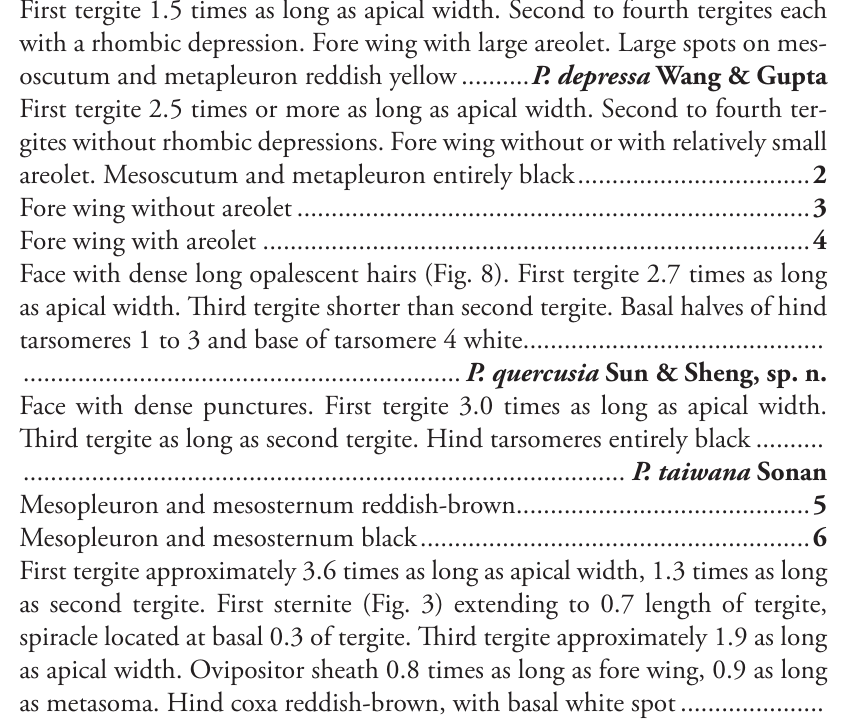
– 5 First tergite approximately 3.6 times as long as apical width, 1.3 times as long as second tergite. First sternite (Fig. 3) extending to 0.7 length of tergite, spiracle located at basal 0.3 of tergite. Third tergite approximately 1.9 as long as apical width. Ovipositor sheath 0.8 times as long as fore wing, 0.9 as long as metasoma. Hind coxa reddish-brown, with basal white spot ..................... ........................................................................... P. maculata Sheng & Sun – First tergite approximately 2.9 times as long as apical width, 1.1 times as long as second tergite. First sternite (Fig. 2) extending to 0.5 length of tergite, spiracle located slightly basal mid of tergite. Third tergite approximately 1.4 as long as apical width. Ovipositor sheath 0.5 times as long as fore wing, 0.45 as long as metasoma. Hind coxa entirely reddish-brown .............. P. brevis Sheng & Sun 6 Ovipositor sheath 0.4 to 0.5 times as long as fore wing. Face with fine, indis- tinct punctures. Lower portion of mesopleuron and propodeum with distinct punctures. .............................................................. P. brachyura Holmgren – Ovipositor sheath at least as long as fore wing. Face with distinct punctures. Sculpture not entirely as above, or lower portion of mesopleuron with indis- tinct punctures, or propodeum with rugae .................................................. 7 7 Lateral portion of pronotum with strong transverse ridge. Areolet uniquely small, 3rs-m approximately 2.8 times as long as 2rs-m, receiving vein 2m-cu at lower posterior corner ................................. P. qinghaiensis Sheng & Sun – Pronotum normal, without transverse ridge. Areolet relatively large, vein 3rs- m at most 2.0 times as long as 2rs-m, receiving 2m-cu distinctly mesad